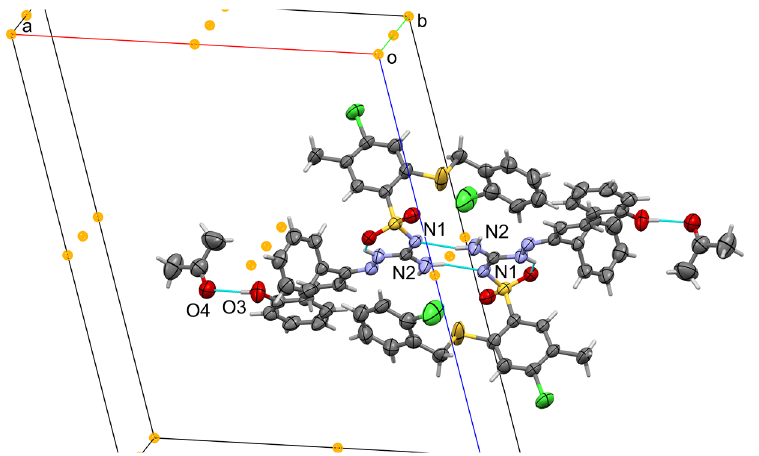
Figure 3. Crystal packing and hydrogen bonding in 24 . Molecules of the main component are linked by the ring-type hydrogen bond motif 𝑅 (cid:2870) ( 8 ) NH . . . N (using N1 and N2 atoms) located at the inversion center (drawn as the orange balls, screw axes, and glide planes not shown). The two acetone molecules are interacting with the sulfonamides through OH..O hydrogen bonds on both sides.